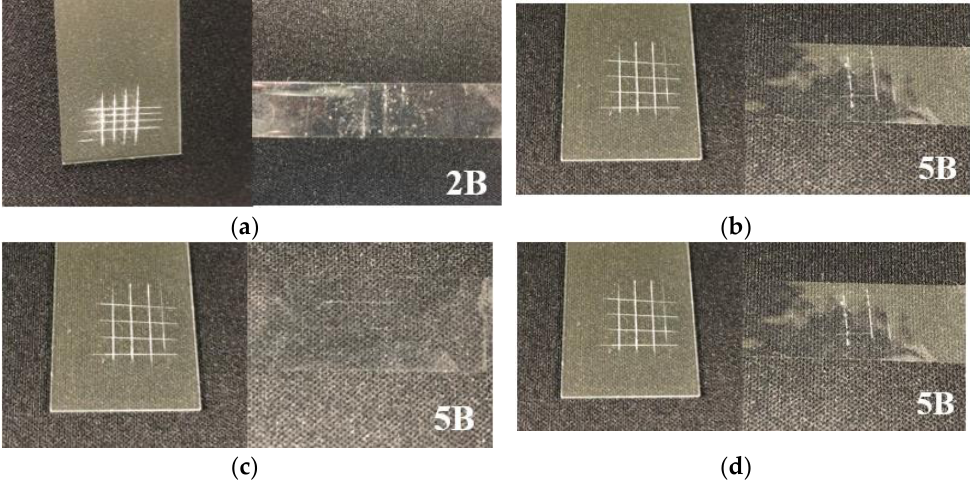
Figure 5. Adhesion characteristics according to the number of coating and annealing: ( a ) natural drying, ( b ) one step, ( c ) two steps, and ( d ) three steps.